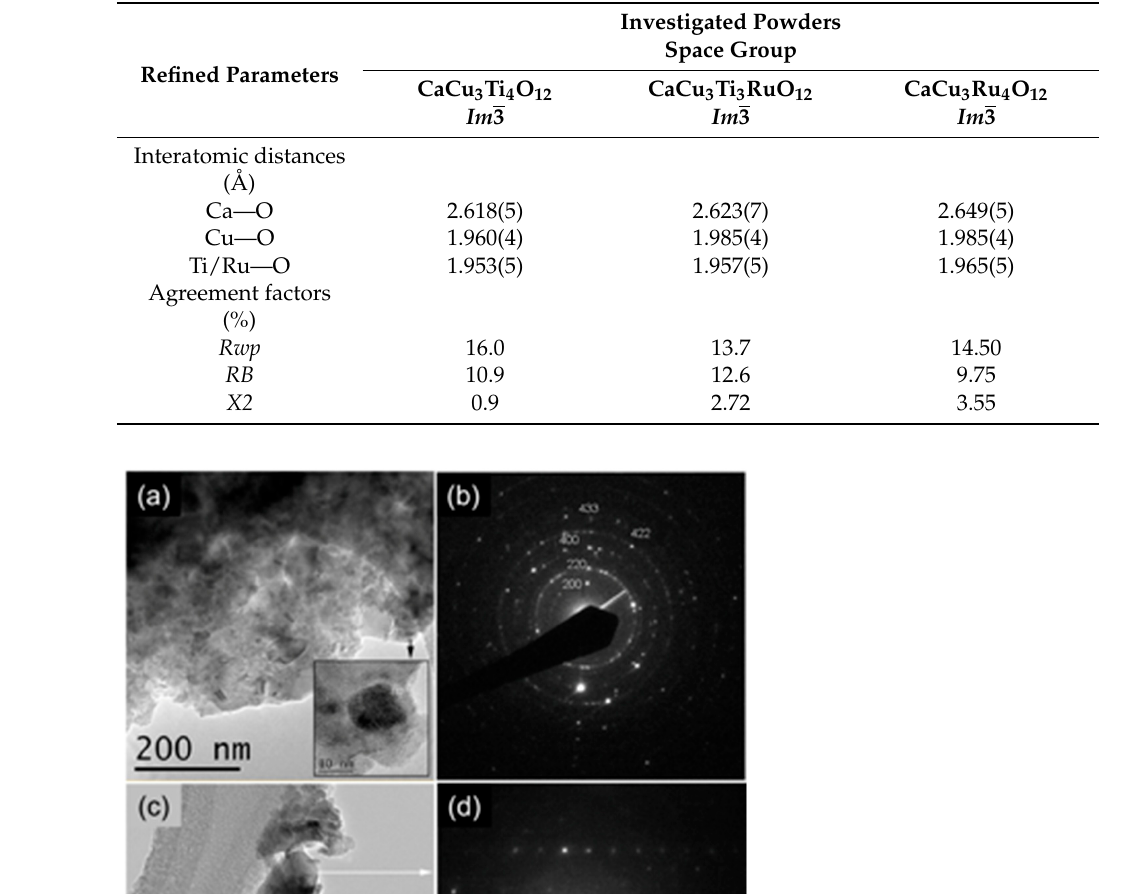
Table 2. The interatomic distances (Å) and reliability factors of CaCu 3 Ti 4 − x Ru x O 12 powders.